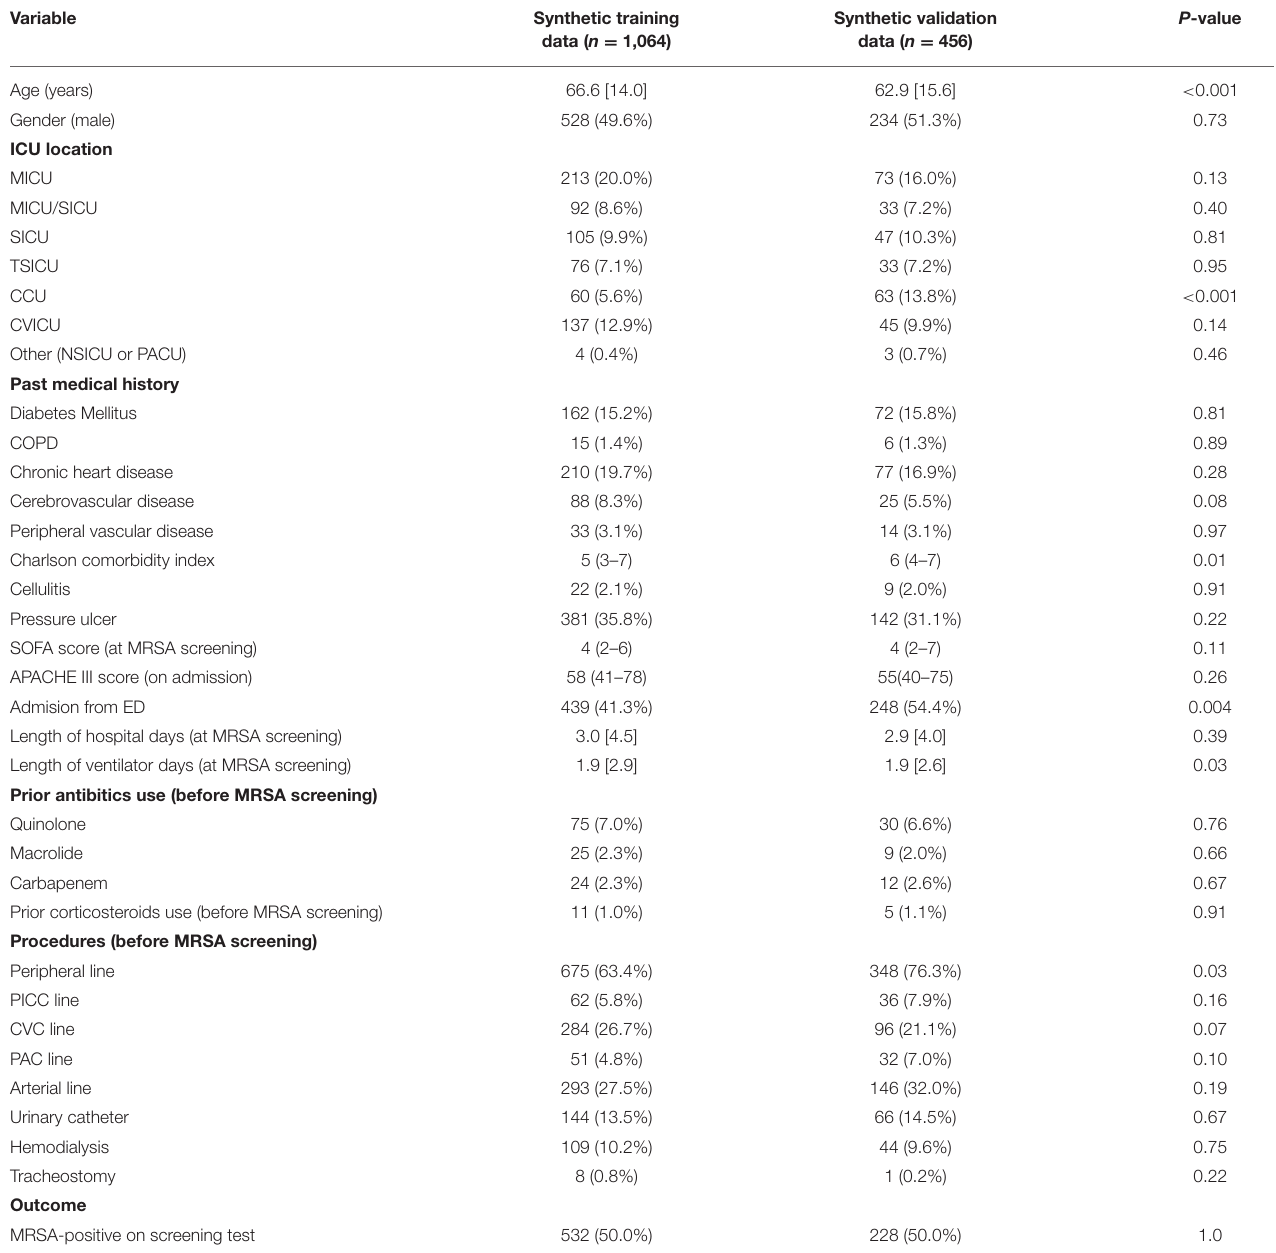
TABLE 1 | Characteristics of the synthetic dataset used for machine